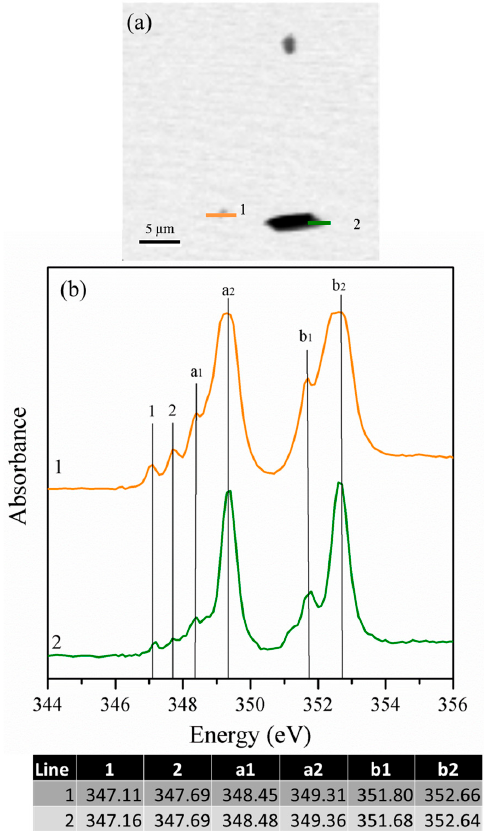
Figure 5. ( a ) Image taken at the calcium L II,III edge of the gypsum sample; and ( b ) NEXAFS of the corresponding line scans.